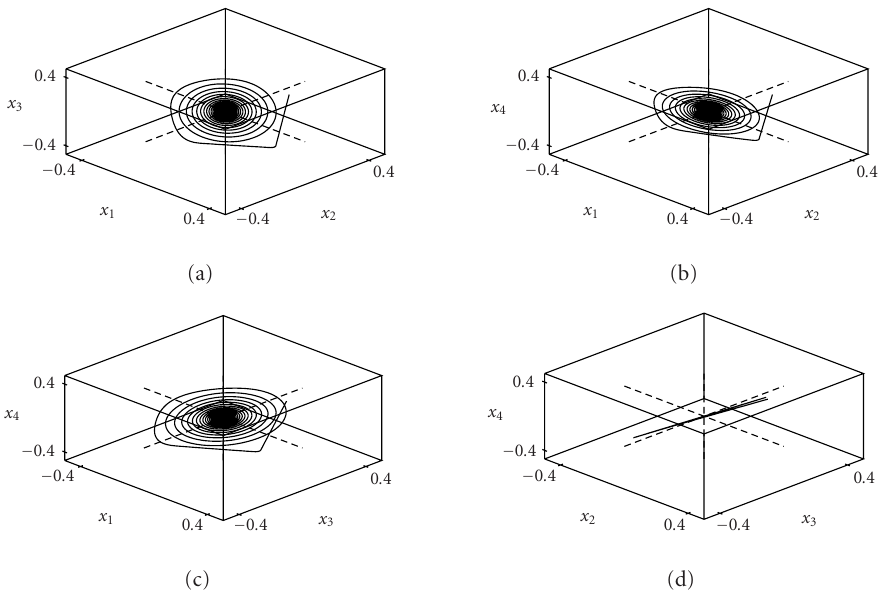
Figure 5.2. The projections in the space with dimension 3 of the orbit of system (5.14) with τ 1 = 1 . 2, τ 2 = 0 . 8, and initial data x 1 ( t ) = x 2 ( t ) = x 3 ( t ) = x 4 ( t ) = 0 . 3, t ∈ [ − 1 .